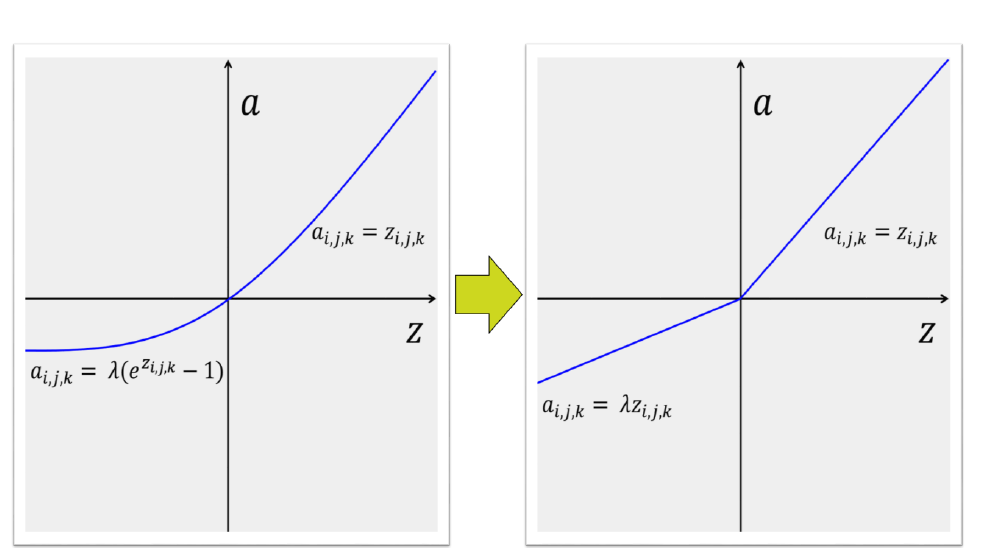
Figure 9. Exponential linear unit ( left ), leaky rectified linear unit ( right ).